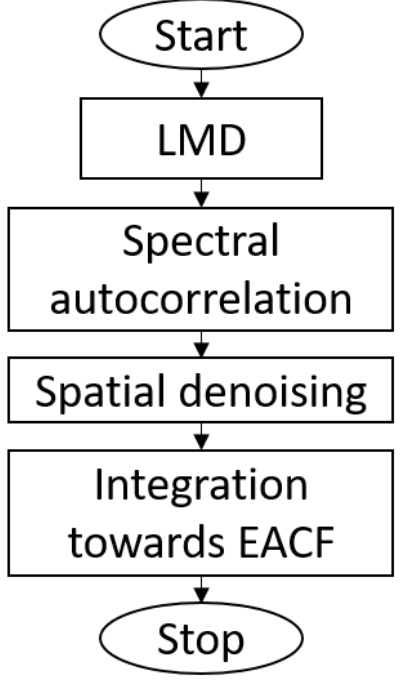
Figure 8. Flowchart of the